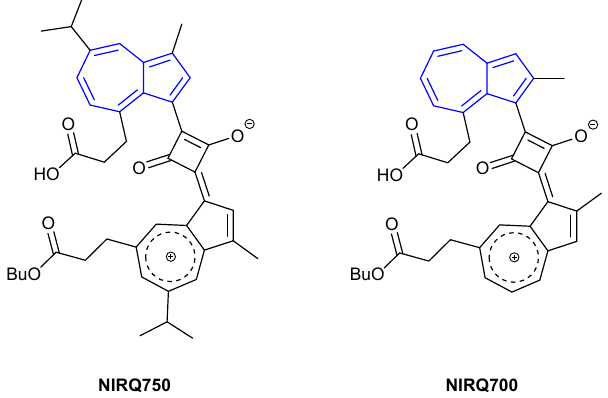
Figure 16. NIR fluorescent quenchers developed by Tung et al. [83] .